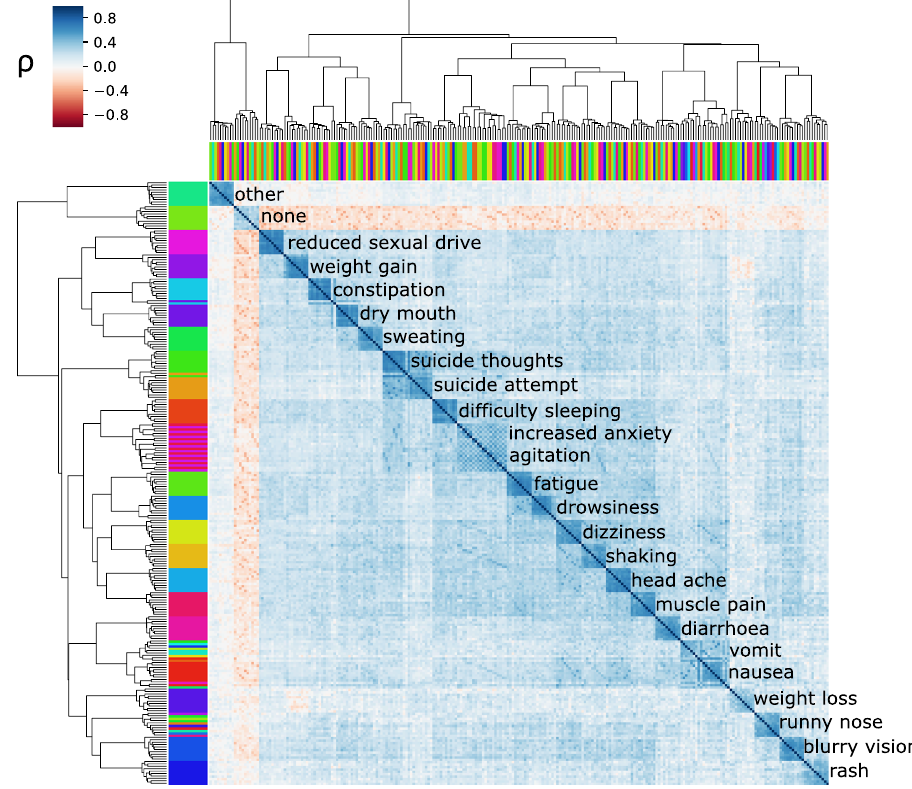
Fig. 2 side effects co-occur across medications. Results of hierarchical clustering based on tetrachoric correlations of the side effects across drugs. The colour shows the correlation (co-occurrence) of patient-reported side effects. The top and side colour bars represent the ten medications and the 25 studied side effects, respectively. Labels show the most abundant side effect in each cluster. ρ - tetrachoric correlation coef fi